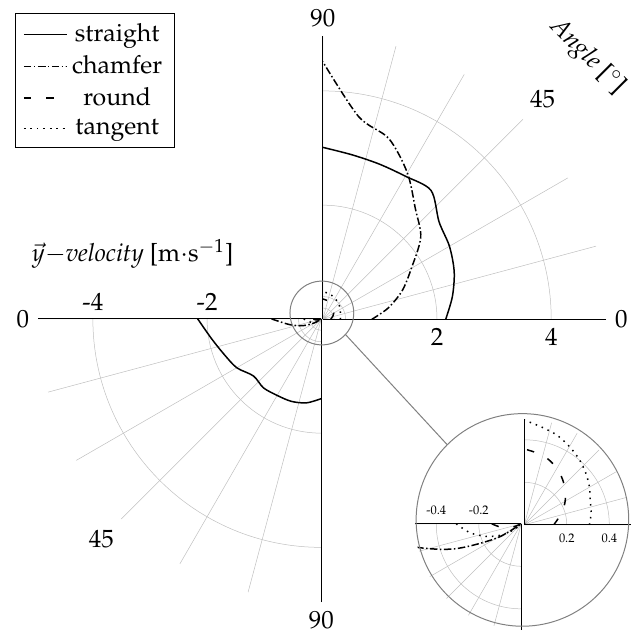
Figure 3. Maximum and minimum velocities in (cid:126) y -direction sampled from C 1 C 2 for all culvert